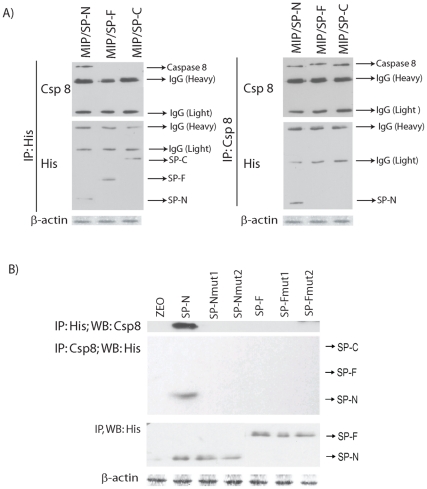
The site of interaction between SPARC and caspase 8 is at the N-terminus of SPARC.Co-localization of the N-terminus of SPARC with caspase 8 was determined by co-immunoprecipitation (IP) studies using whole protein extracts. A) Only the recombinant N-terminus containing His-tagged fusion protein from MIP/SP-N cells co-IP with caspase 8 in a reciprocal fashion. B) Mutations in the N-terminus domain of SPARC (SP-Nmut1, SP-Nmut2) abolishes this interaction with caspase 8, and only the wild-type SP-N interacted with caspase 8. As additional controls, neither the wild type nor the mutant FS domain (SP-Fmut1, SP-Fmut2) interacted with caspase 8.